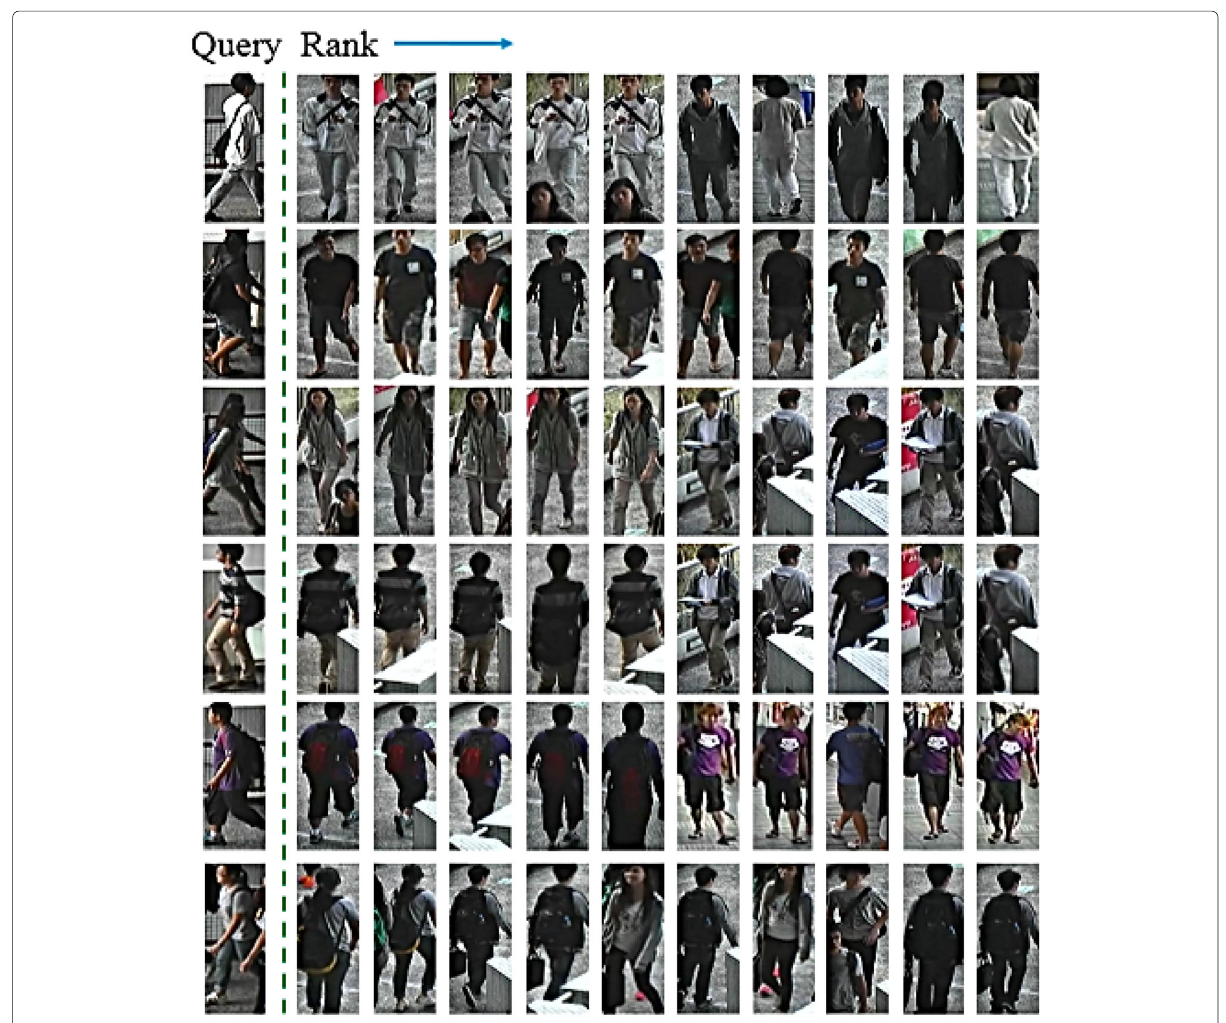
Fig. 6 Samples of pedestrian retrieval on CUHK03 database in the multi-shot setting. The first column indicates query images, and remaining columns are gallery images which are sorted according to the scores from left to